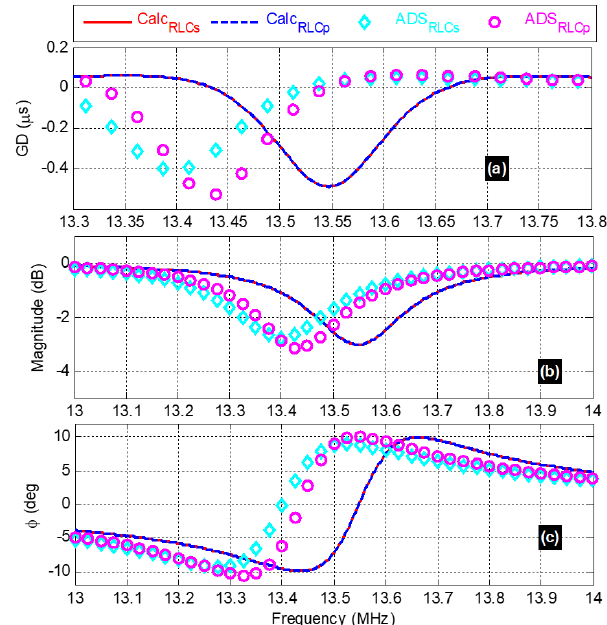
FIGURE 4. Comparisons of calculated and simulated VTFs: (a) GD, (b) magnitude and (c) phase from the RLC-series and RLC-parallel circuits shown in Figs. 2 and Figs. 3.